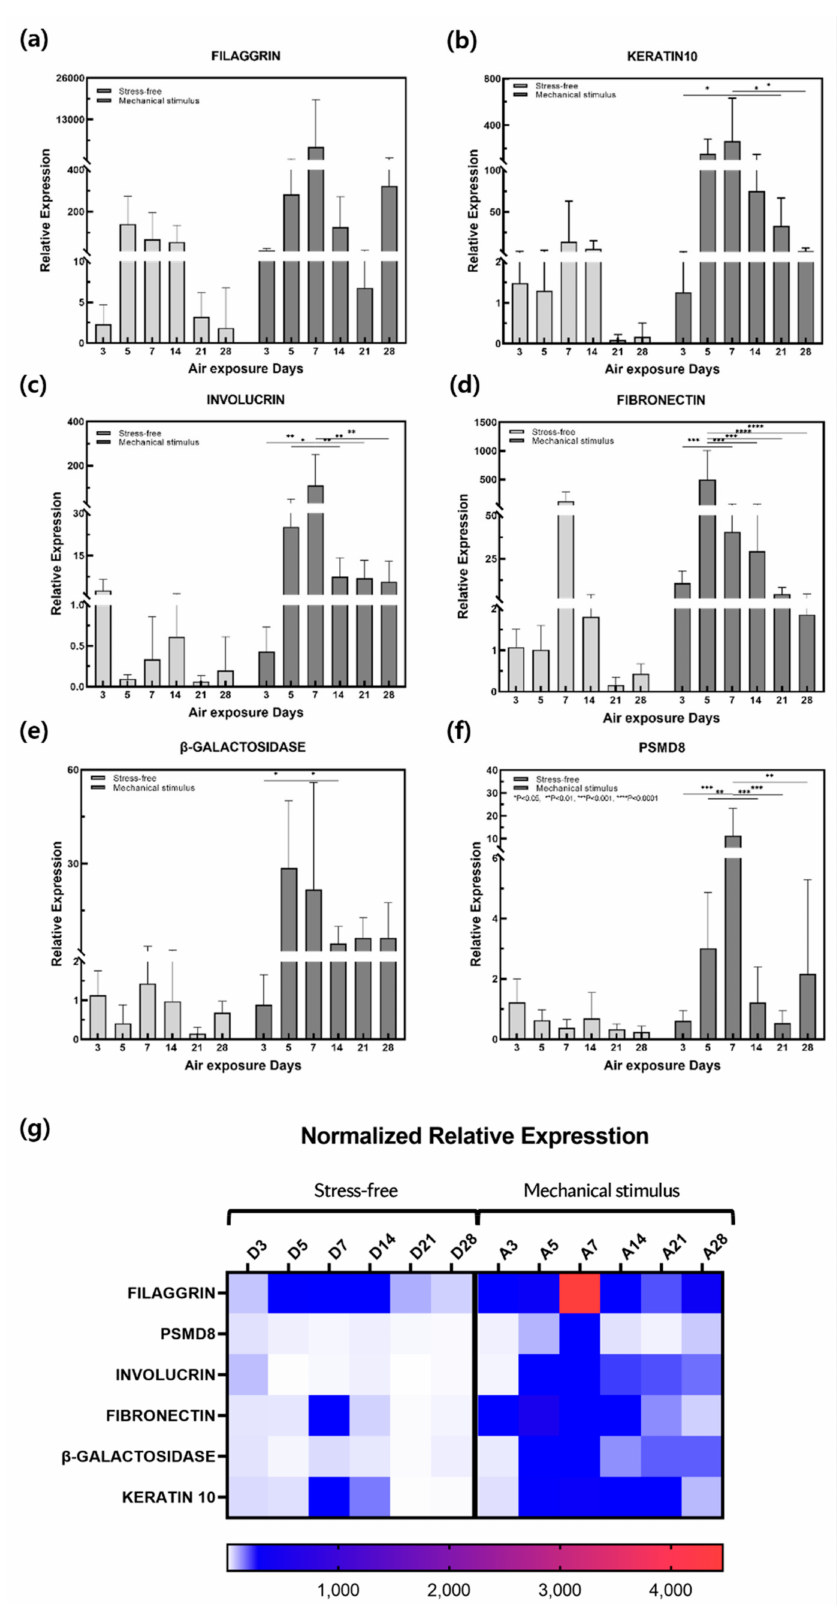
Figure 3. Relative gene expression of ( a ) filaggrin, ( b ) fibronectin, ( c ) involucrin, ( d ) keratin 10, ( e ) β -galactosidase, and ( f ) PSMD8 in samples with and without compressive stimulation as a function of the air exposure days. ( g ) Normalized relative expression for ( a – f ). ( n = 5; *, p < 0.05; **, p < 0.01; ***, p < 0.001; ****, p <